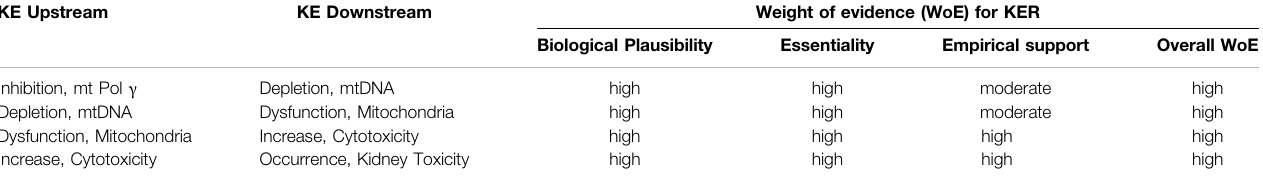
TABLE 3 | Weight-of-evidence analysis of KERs in the adverse outcome pathway of inhibition of mitochondrial DNA polymerase γ leading to kidney toxicity. KE Upstream KE